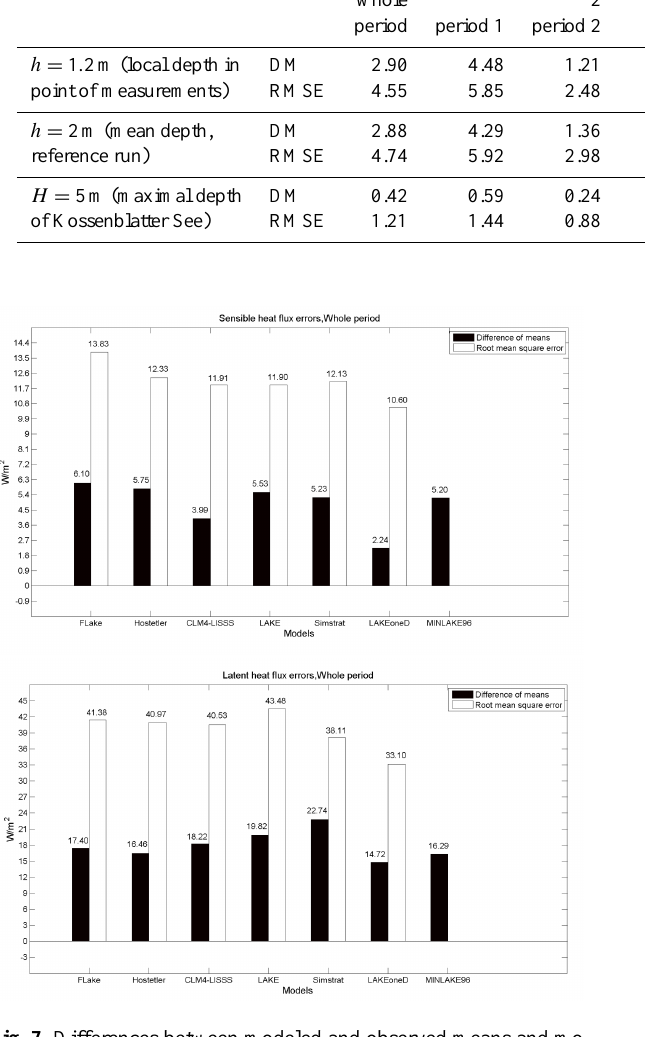
Fig. 7. Differences between modeled and observed means and mo- dels’ RMSEs of sensible and latent heat flux. The mean mea- sured sensible heat flux is 8Wm − 2 , and mean latent heat flux is 69Wm − 2 .